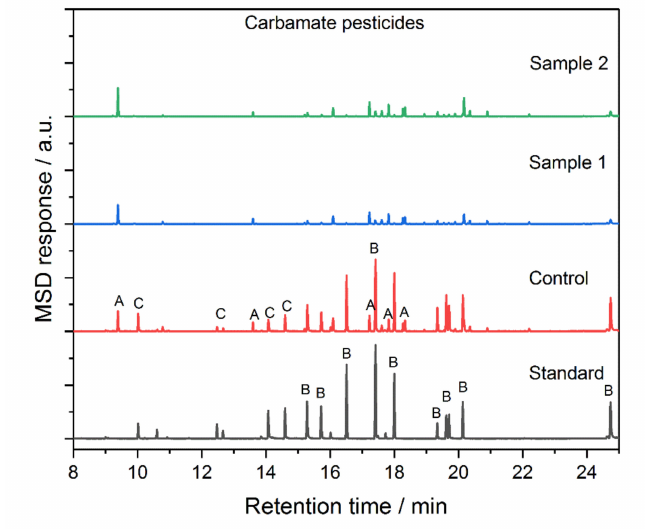
Figure 11. GC chromatograms of carbamate pesticides under di ff erent